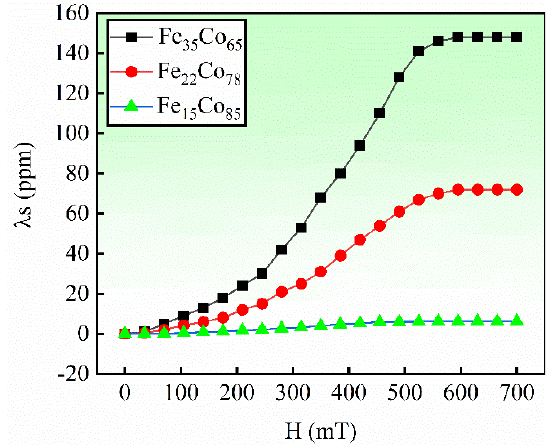
Figure 5. Magnetostriction curves of Fe 35 Co 65 , Fe 22 Co 78 , Fe 15 Co 85 .